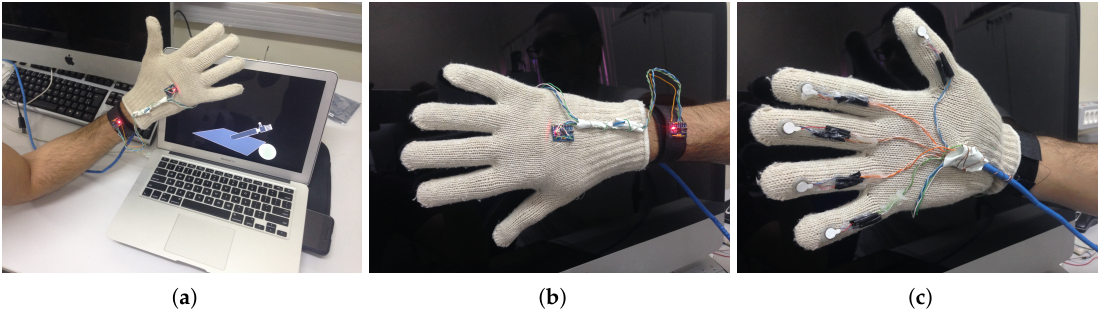
Figure 6. The final result of the design of the proposed glove. ( a ) Tactile glove and slave device (PC with virtual robotic arm). ( b ) Position of inertial measurement units (IMUs) (motion tracking device) in the tactile glove. ( c ) Position of all fingers’ actuators (five vibration actuators) in the tactile glove.